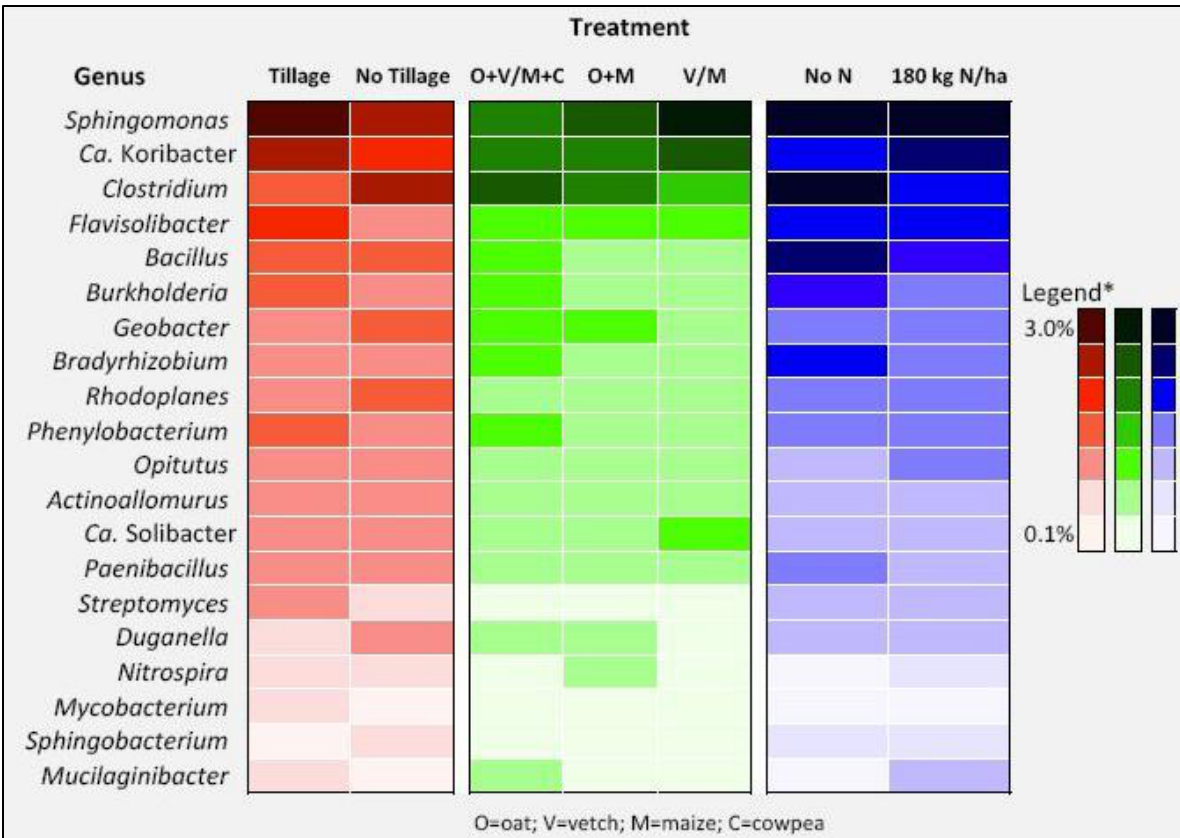
Figure 2. Heatmap illustrating the 20 most abundant genera, in the three treatments. Different gradient color on the line represents significant difference ( p -value ≤ 0.01) by Tukey